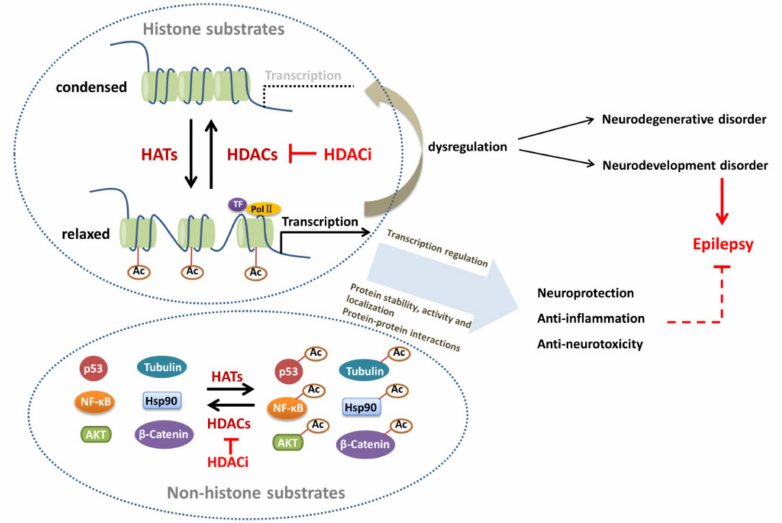
Figure 1. The mechanisms of protein acetylation/deacetylation modifications in neurological